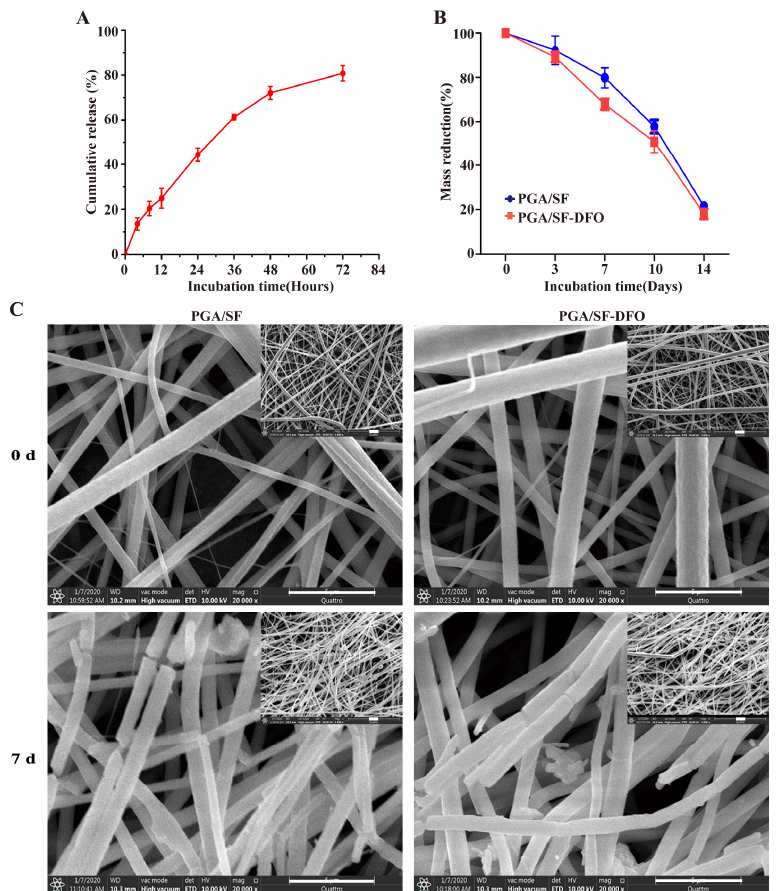
Figure 3. Drug release behavior and biodegradable profile of different scaffolds. ( A ) Cumulative release of DFO from PGA/SF-DFO scaffolds in vitro. ( B ) Mass reduction of different scaffolds over 14 days. ( C ) Representative SEM images of different degraded scaffolds at day 0 and 7 in vitro (scale bar = 5 µ